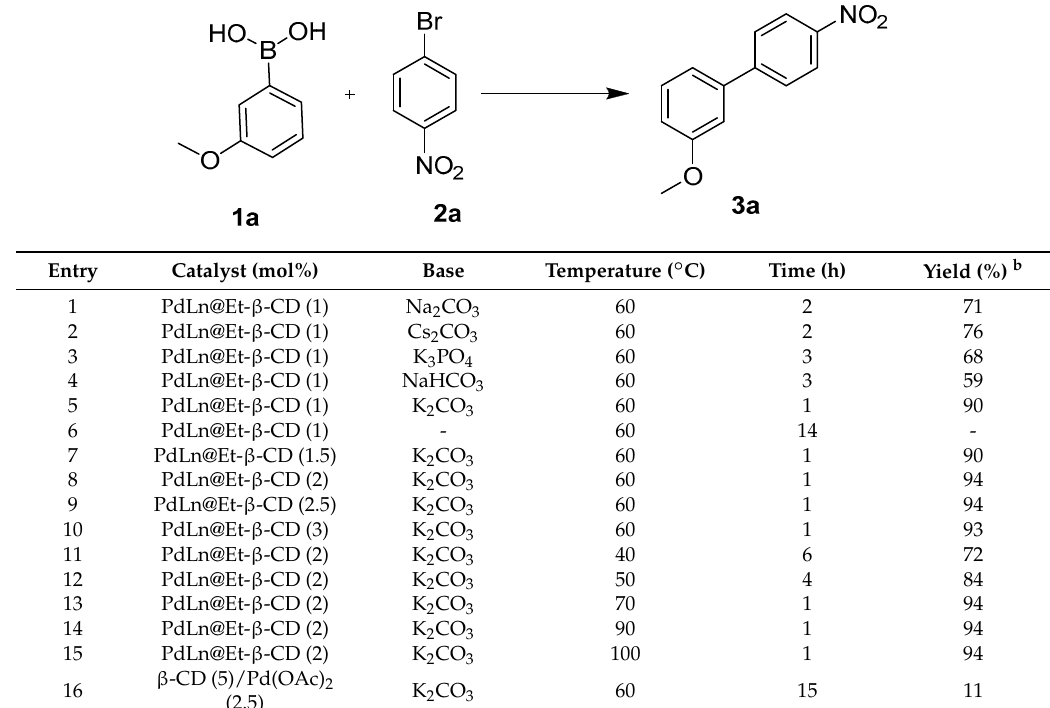
Table 1. Optimization of the reaction conditions a .